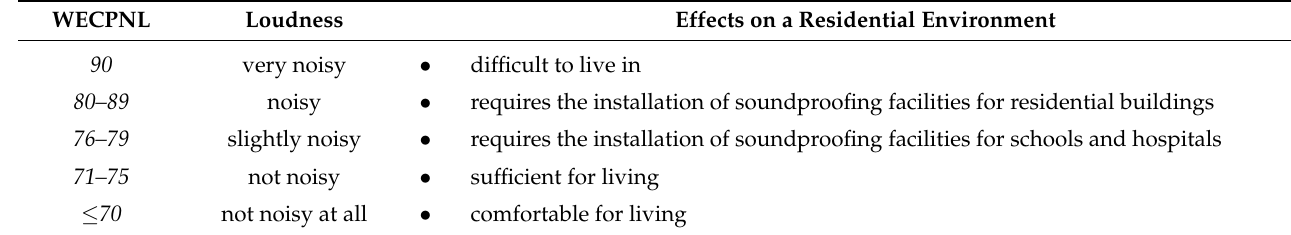
Table 1. Effects of aircraft noise on a residential environment